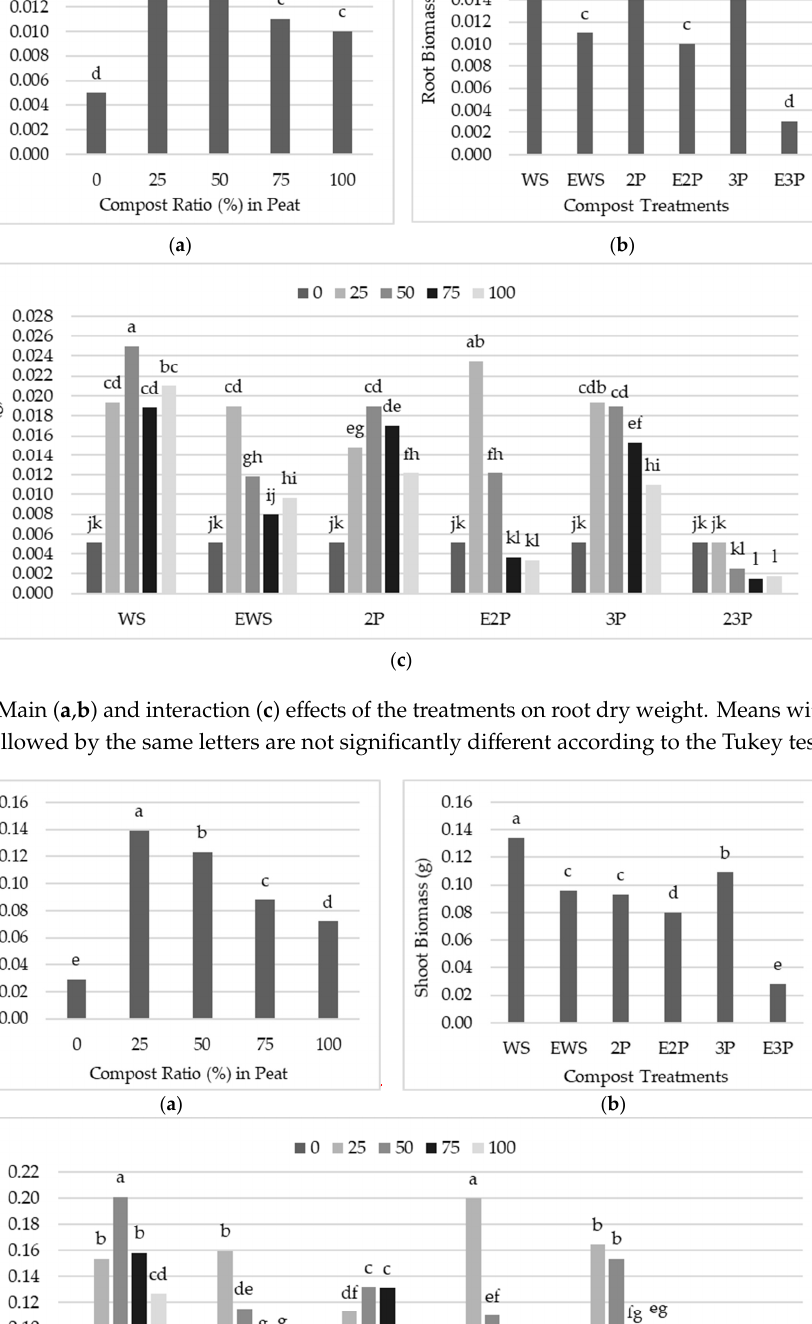
Table 7. Effects of the treatments on chlorophyll index values (SPAD). Compost Ratios in Peat (%)